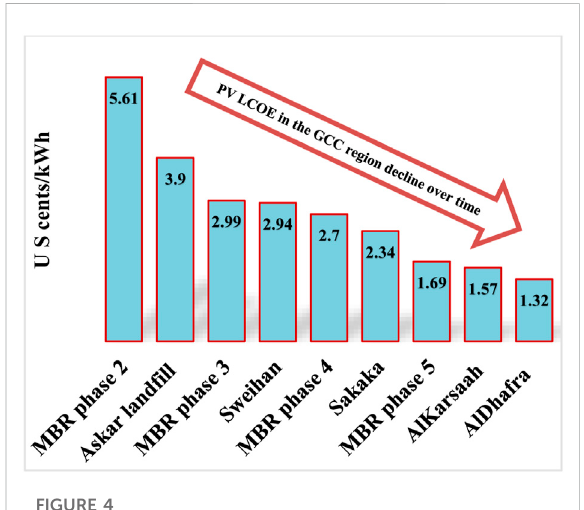
FIGURE 4 The LCOE of the existing solar project in the GCC region.